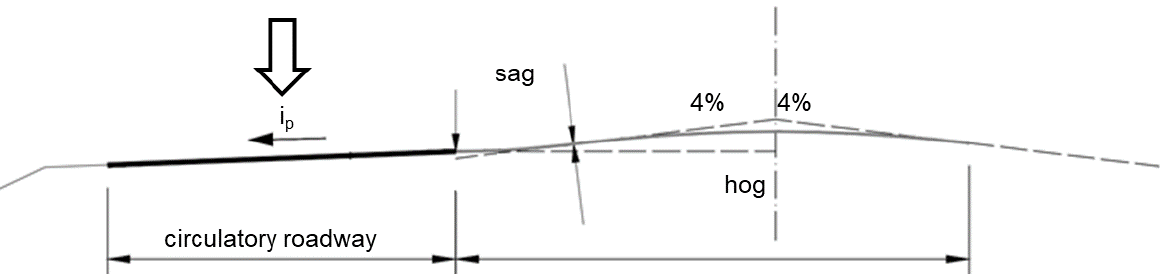
Figure 11. Central island design [10].